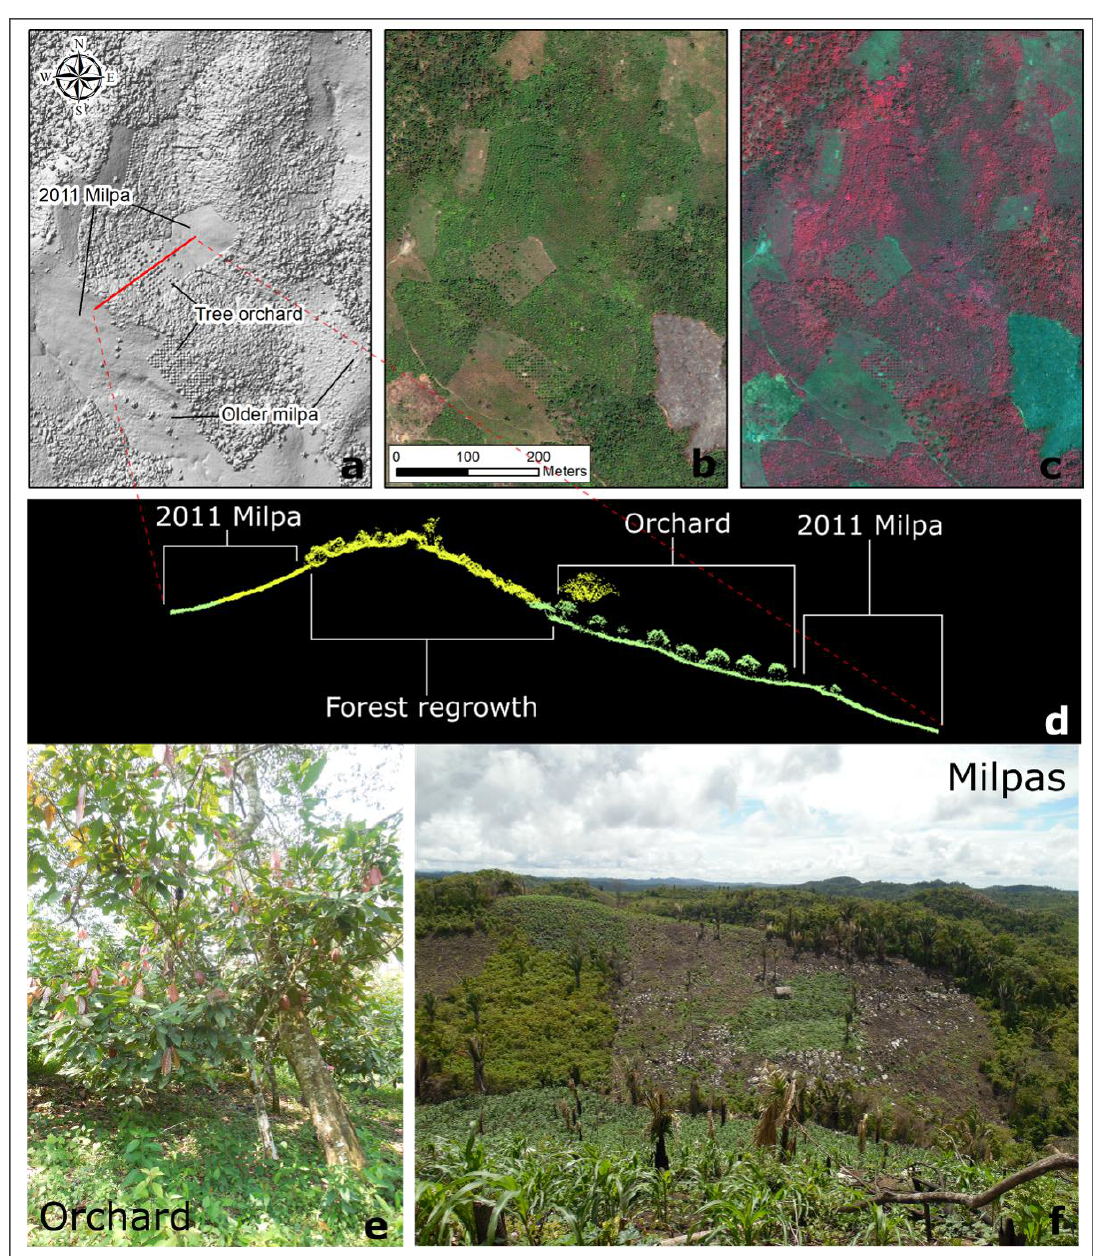
Figure 12. Vegetation type and height impacts archaeological prospection. ( a – c , f ) Shifting agriculture and ( a – c , e ) tree orchards have differing effects on the ( d ) lidar cloud, creating a mosaic landscape.